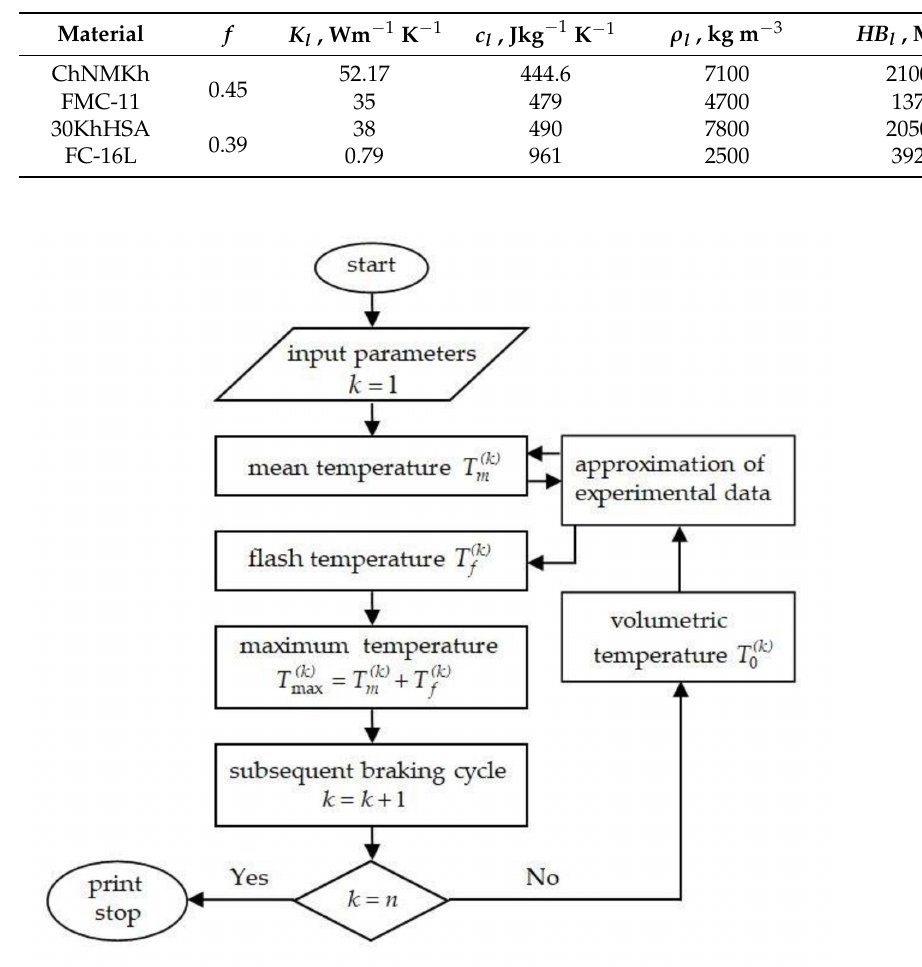
Figure 2. Flowchart of the calculation procedure. Experimental data of frictional thermal stability and property variations under differ- ent temperature conditions of friction materials ChNMKh/FMC-11 and 30KhHSA/FC-16L are included in [9,26]. The values of coefficients in the functions (4)–(8), which approximate these data, are presented in Table 2. In this paper, it was assumed that density ρ l of all selected materials changes slightly under temperature variations, so Equation (7) takes the ( T ) = 1, l = 1, 2. Graphs of functions f ( T ) (4), K form ρ ∗ l l = 1, 2 (8) are presented in Figure